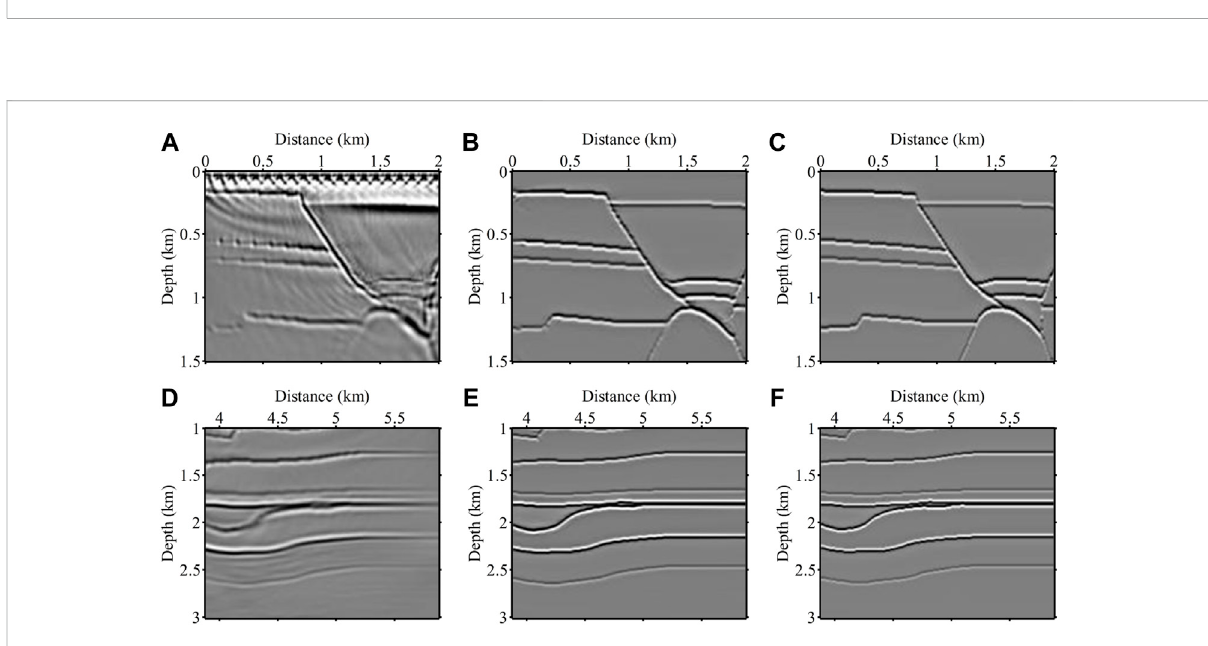
migrated image of RTM has more low-frequency noise in the shallow layer due to the blurring fi ltering of Hessian matrix. At the same time, the imaging resolution of the model bottom structure is low due to the in fl uence of the deep high-speed layer shielding. Figure 8D shows the result of network prediction.